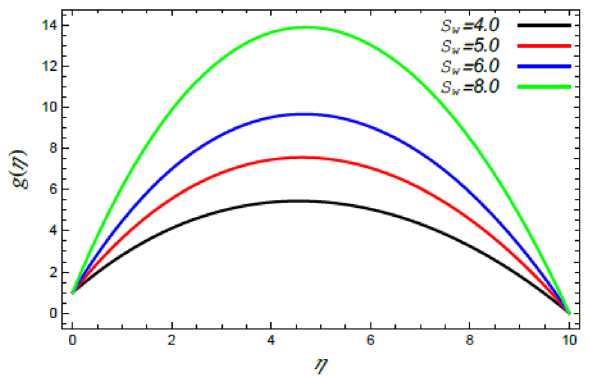
Figure 9. Deviation of the azimuthal velocity g (η) versus η as given in Eq. (65) to illustrate the impact of the Stefan blowing factor S w .